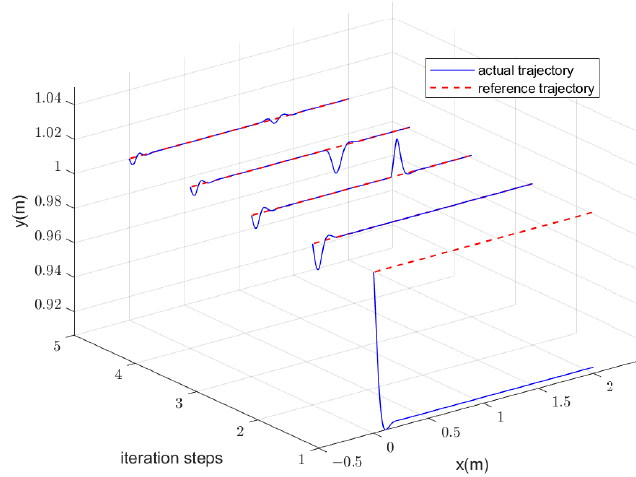
Figure 14. Iterative tracking plots under constant wind speed, water flow disturbances, model mismatch, and transient disturbances.